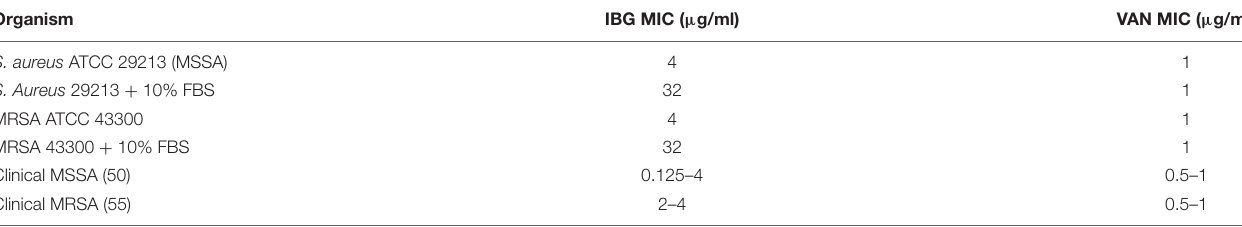
TABLE 1 | Activity of IBG against Staphylococcus aureus . Organism